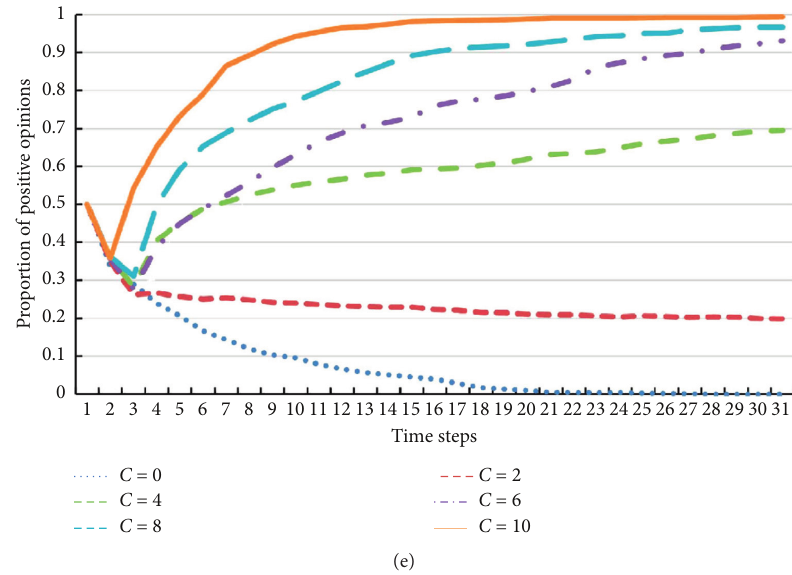
Figure 2: The evolution trends for the initial proportions pp � 0 . 1 , 0 . 2 , 0 . 3 , 0 . 4 , and 0 . 5, opinion control levels k � 0 , 1 , 2 , 3 , 4 , and 5, and � 20 and m � 5. (a) The initial proportion pp � 0.1, C � 2, 4, 6, 8, and 10, and L � 0.5. (b) The initial L � 0 . 5 in scale-free networks with m 0 proportion pp � 0.2, C � 2, 4, 6, 8, and 10, and L � 0.5. (c) The initial proportion pp � 0.3, C � 2, 4, 6, 8, and 10, and L � 0.5. (d) The initial proportion pp � 0.4, C � 2, 4, 6, 8, and 10, and L � 0.5. (e) The initial proportion pp � 0.5, C � 2, 4, 6, 8, and 10, and L �